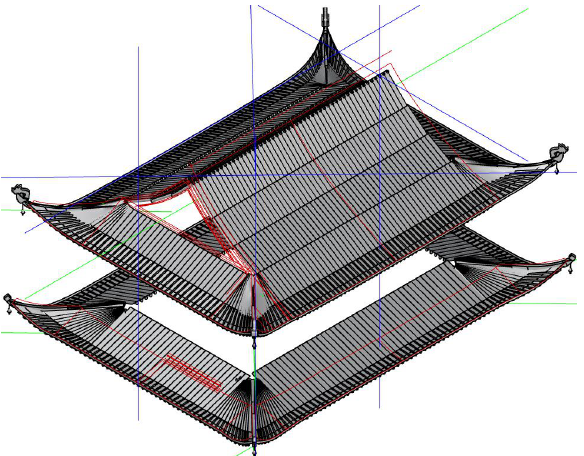
Figure 23. Rafters and accessories